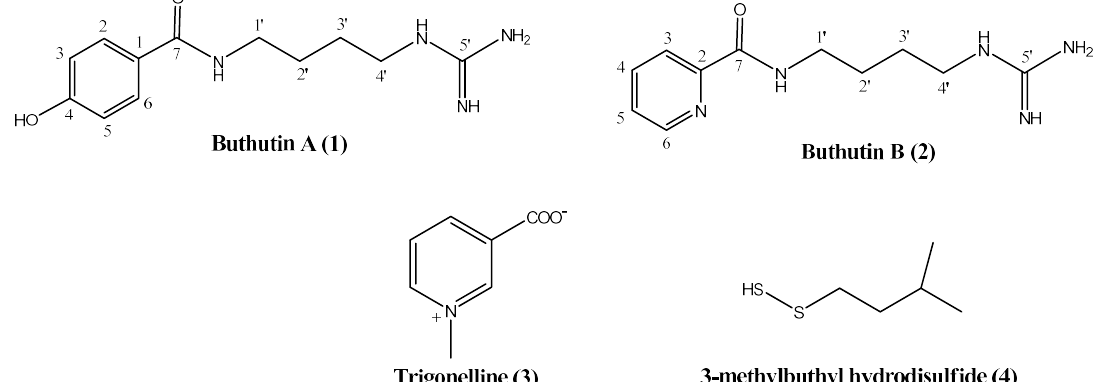
Figure 1. Chemical structures of compounds ( 1 – 4 ) from B. martensii .